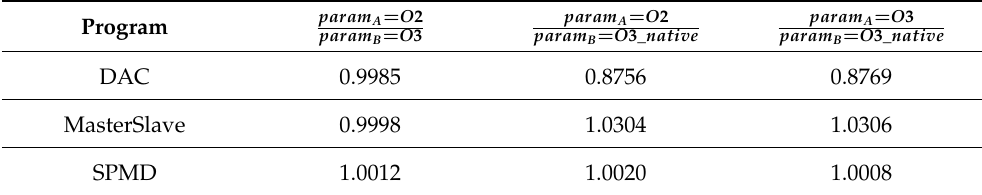
Table 5. Execution time factor for parameters (results of p function).